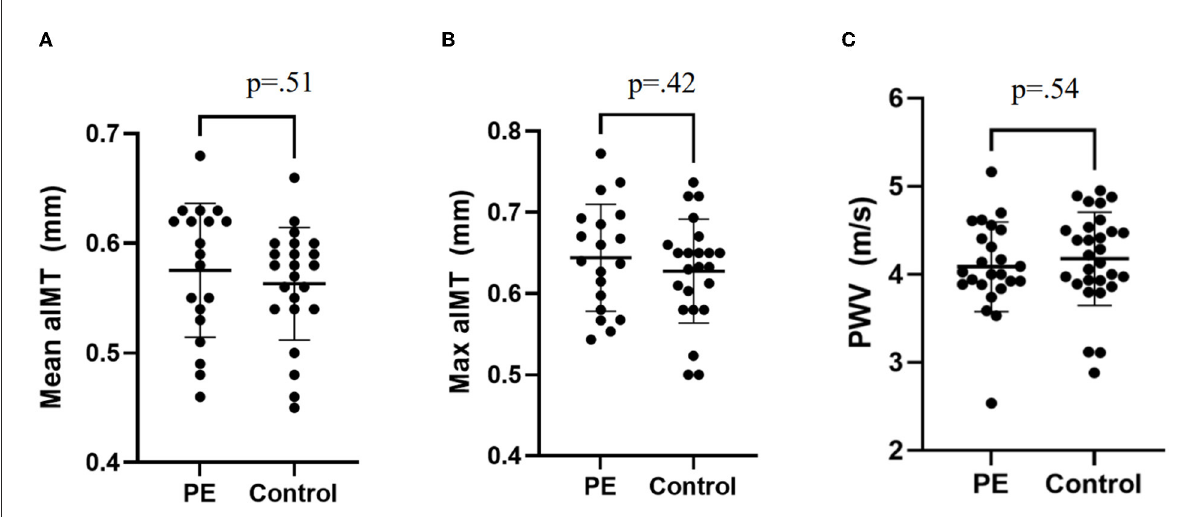
FIGURE2 Individual patient data for vascular measures. (A) Mean aIMT, (B) Maximum aIMT, and (C) Pulse wave velocity. Plots presented as mean ± SD. PE, Preeclampsia.